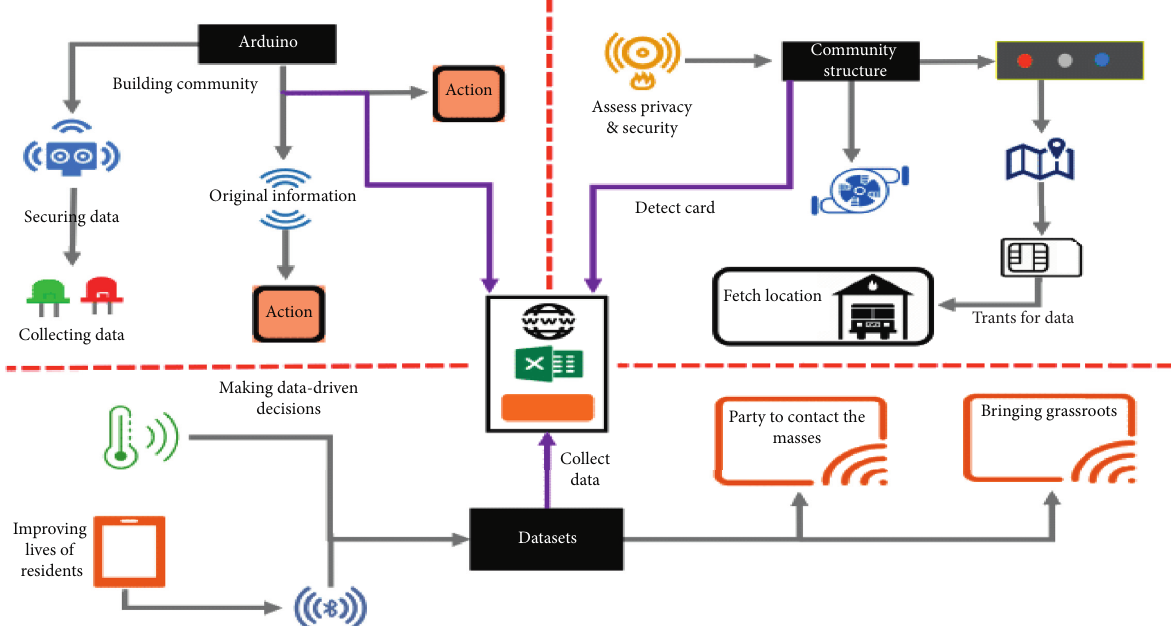
Figure 2: Optimal design of smart city community